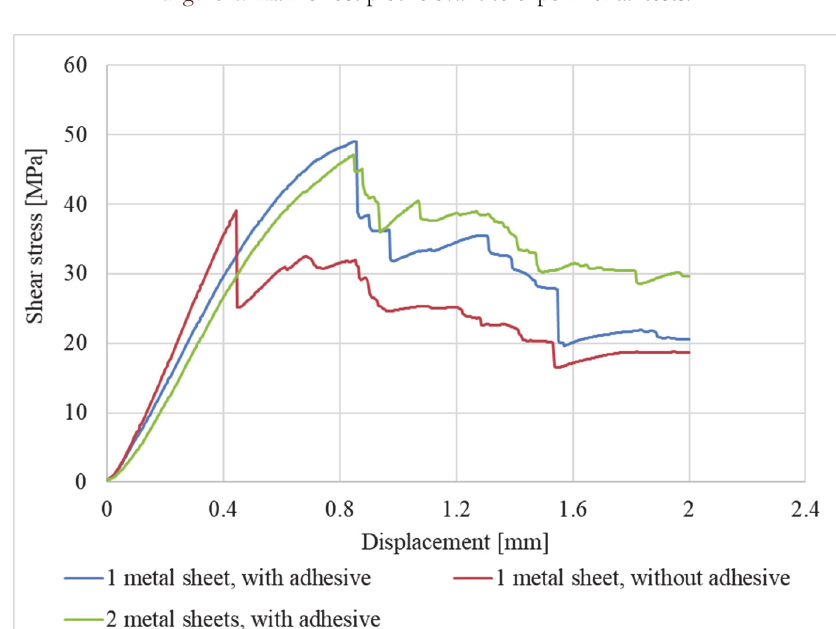
Figure 5: Shear stress as a function of displacement for the tested